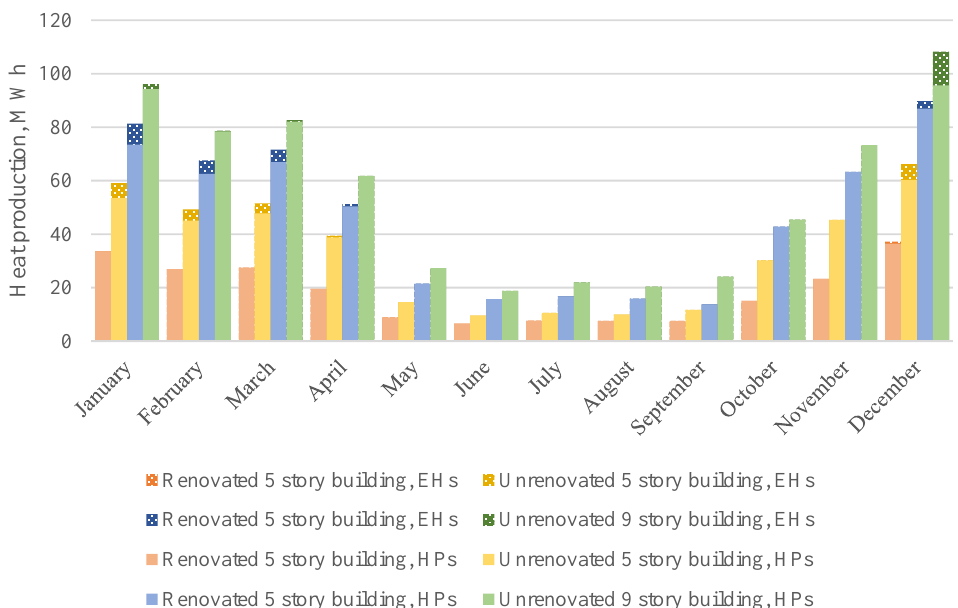
Figure 8. Comparison of heat production in renovated and unrenovated apartment buildings.